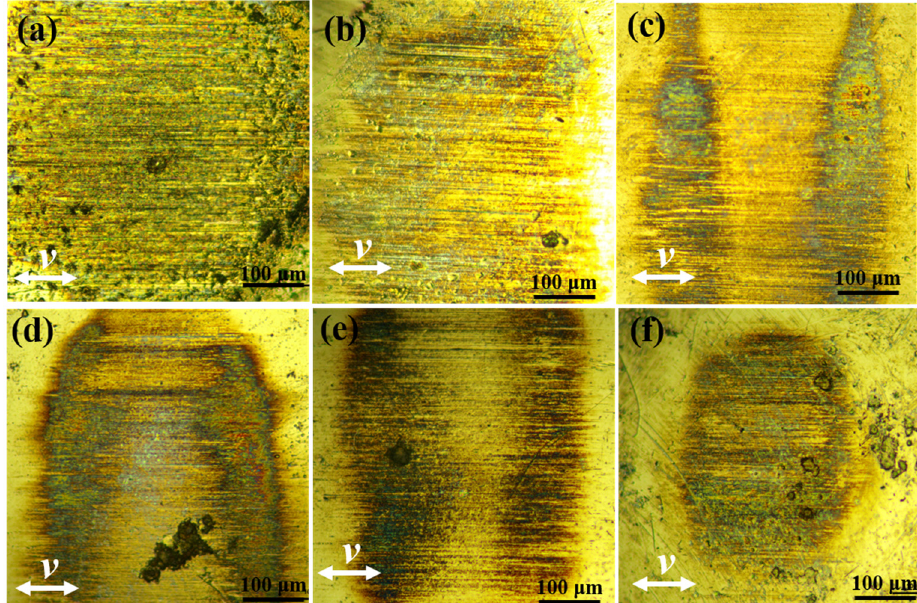
Figure 8. Worn surfaces of counterpart ball sliding against: ( a ) FGr@MoS 2 -0; ( b ) FGr@MoS 2 -0.3; ( c ) FGr@MoS 2 -0.6; ( d ) FGr@MoS 2 -0.9; ( e ) FGr@MoS 2 -1.2; ( f ) FGr@MoS 2 -1.